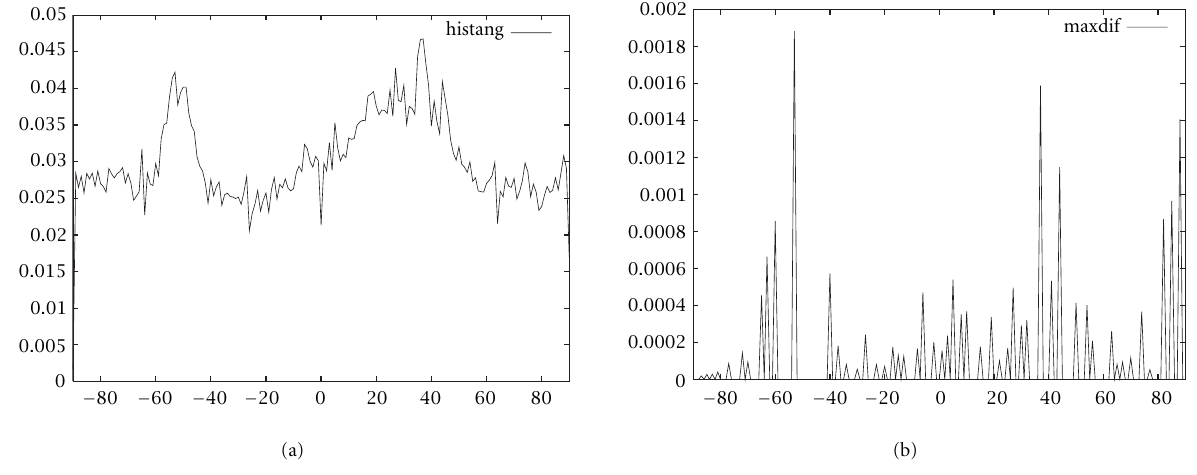
Figure 9: (a) Plot of λ(θ i ) and (b) p(θ i ) for the map in Figure 8. Though less evident that in Figures 6 and 7 the maximum of p(θ i ) permits to determine the true text orientation ( − 53